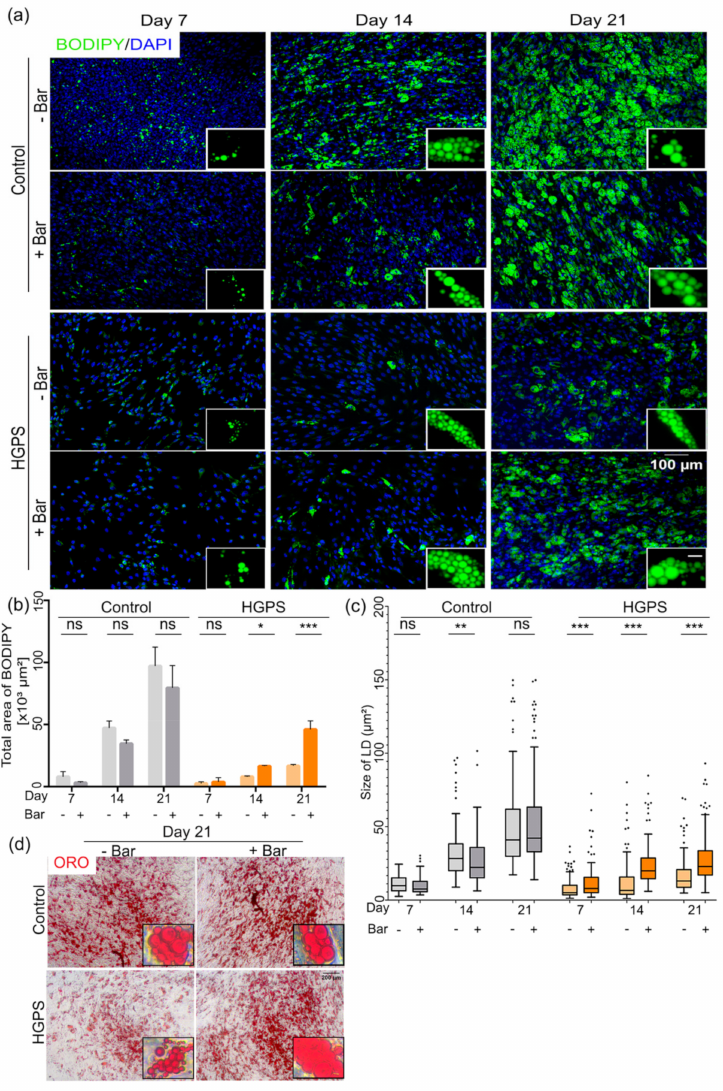
Figure 7. Improved differentiation of HGPS SKPs after treatment with baricitinib. ( a ) Bodipy staining of control (GMO5567A) and HGPS (HGADFN127) differentiated adipocytes after treatment with baricitinib. Scale bar: 100 µ m; for the magnified images, scale bar: 20 µ m. Cells were counterstained with DAPI. ( b , c ) Quantification of total area showing Bodipy signal and average size of lipid droplets (LD) at days 7, 14, and 21 of differentiation for both control and HGPS adipocytes. ( d ) ORO images at day 21 of differentiation for control and HGPS adipocytes. ( b ) Values are presented as mean ± SD ( n = 3), ( c ) In the box and whisker plot, the horizontal line crossing the box is the median, the bottom and top of the box are the lower and upper quartiles, the whiskers are the minimum and maximum values, and the dots represent the outliers, not significant (ns), * p < 0.05, ** p < 0.01, *** p < 0.001, ( b ) two-way ANOVA with Tukey’s multiple comparisons test, ( c ) unpaired t